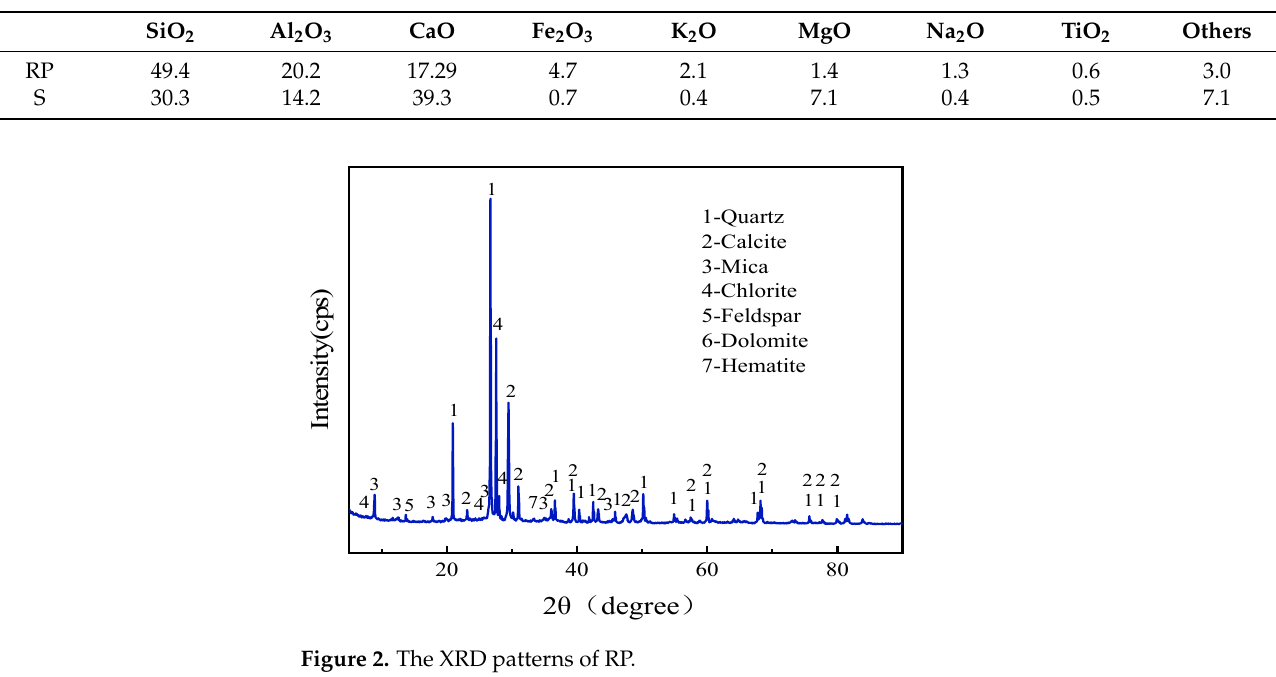
Figure 1. The preparation process of RP. Table 1. The chemical compositions of RP and slag.